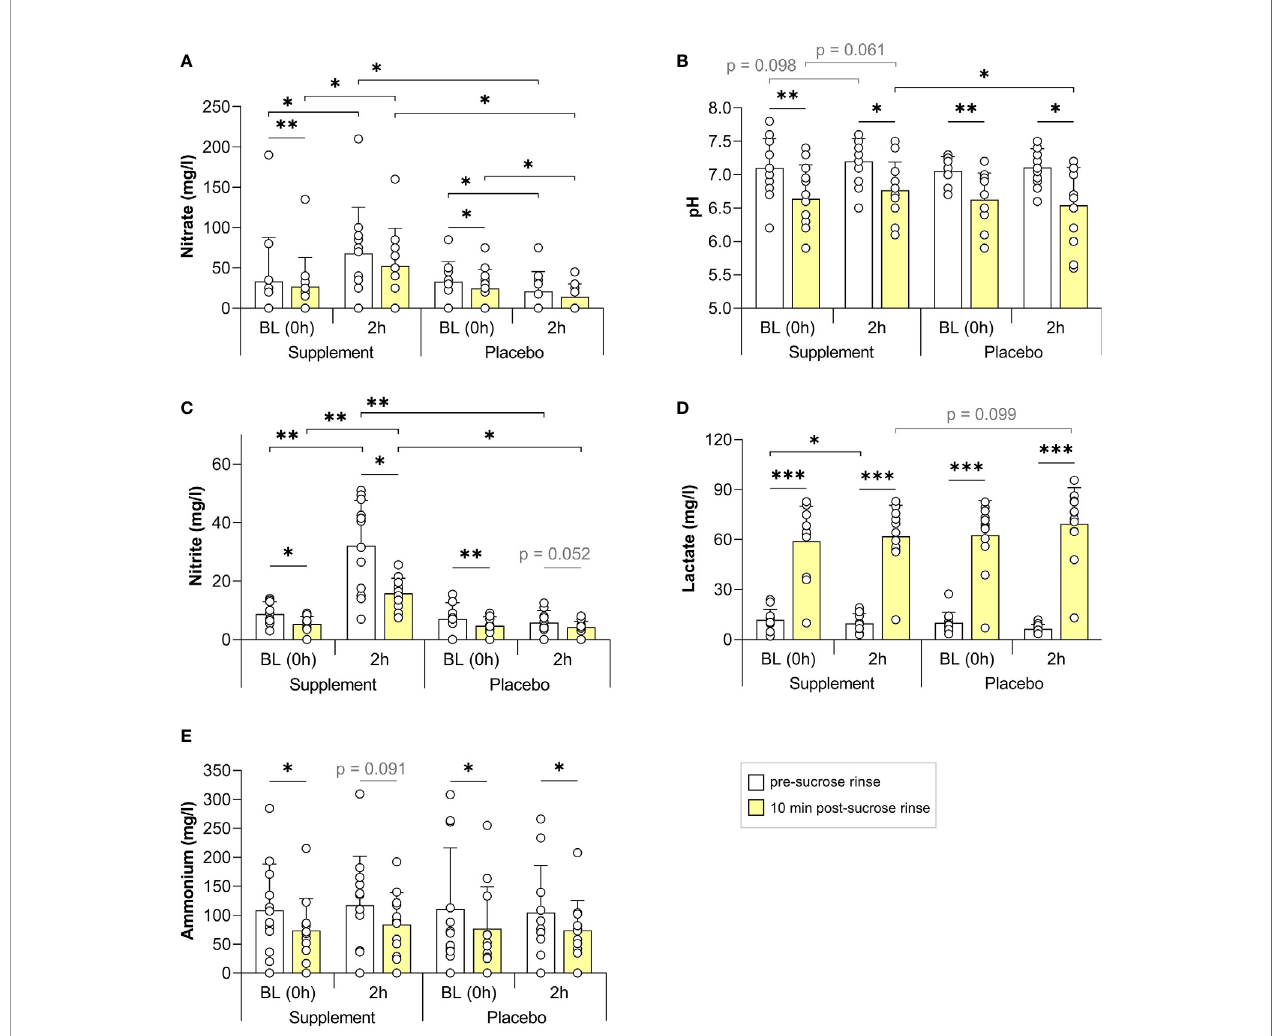
FIGURE 2 | The effect of a nitrate-rich supplement on sucrose rinses 2 h after intake compared with a placebo. In 12 individuals, salivary nitrate (A) , pH (B) , nitrite (C) , lactate (D) and ammonium (E) were measured. Sugar rinses were performed at baseline (BL, 0 h) on the two different days (supplement day and placebo day) and 2 h after intake of a nitrate-rich supplement (250 mg nitrate in 250 ml) or nitrate-poor placebo (<6 mg nitrate in 250 ml). Saliva samples were collected immediately prior to the sugar rinse (pre-sucrose, white bars) and 10 min after the sugar rinse (post-sucrose, yellow bars). The bars and small white circles represent the averages and individual donor ’ s data, respectively. Wilcoxon tests were used to compare the pre-sucrose with the post-sucrose measurements. Additionally, the BL pre- and post-sucrose measurement were compared with 2 h pre- and post-sucrose measurement, respectively. Finally, every measurement on the supplement day was compared with the same measurement on the placebo day. Signi fi cant changes (*p < 0.05, **p < 0.01, ***p < 0.005) and trends (grey text, p = 0.05 - 0.1) are